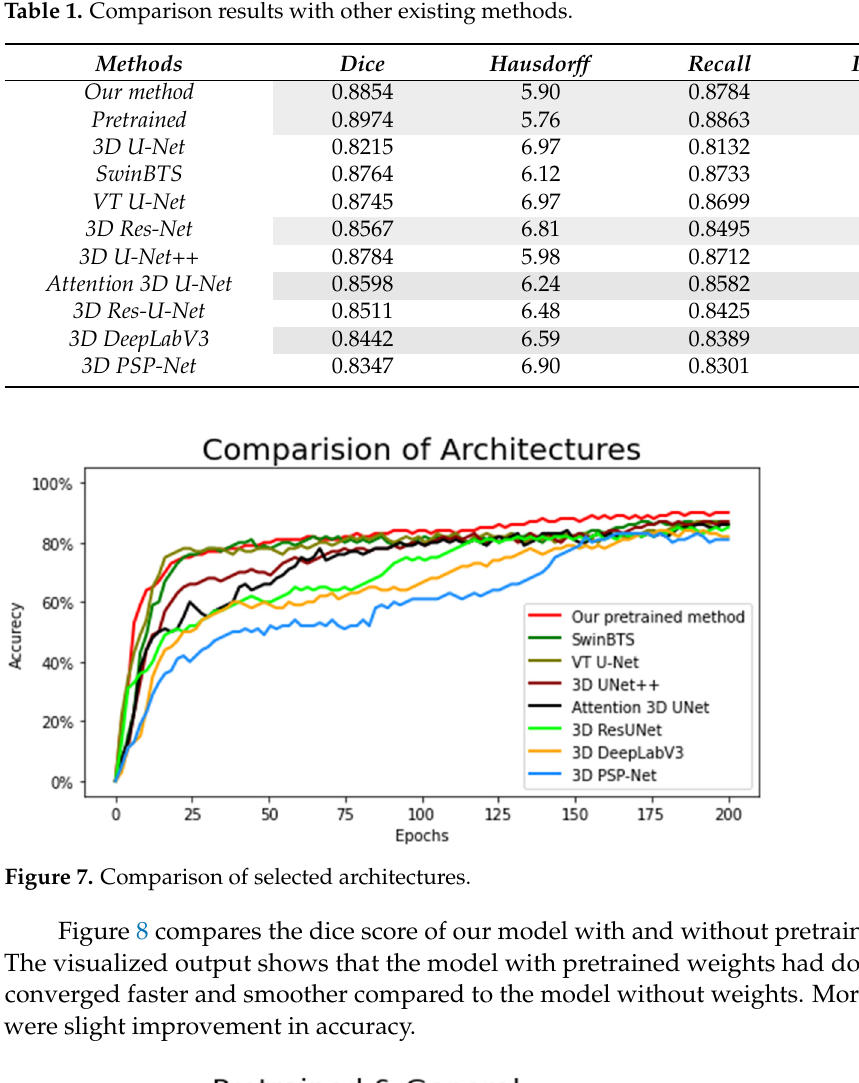
Table 2. Complexity of models used in comparison process. Methods